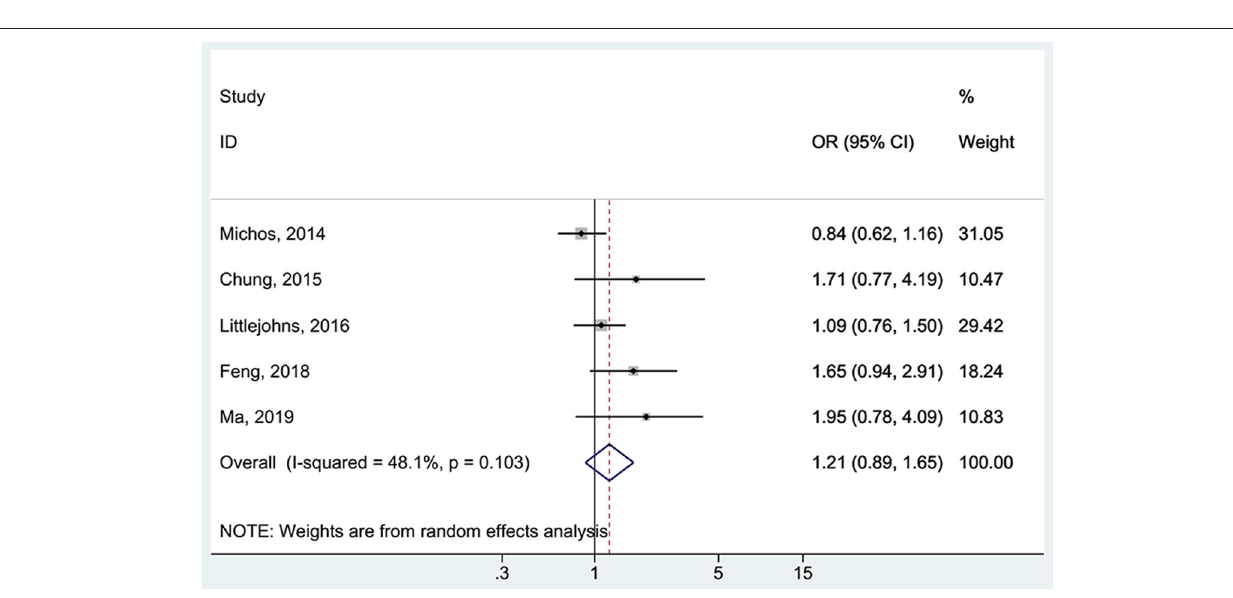
FIGURE 3 | Forest plot of insufficient vs. sufficient vitamin D level. % Weight represents the contribution of the sample size of each study to the total number of patients included in the